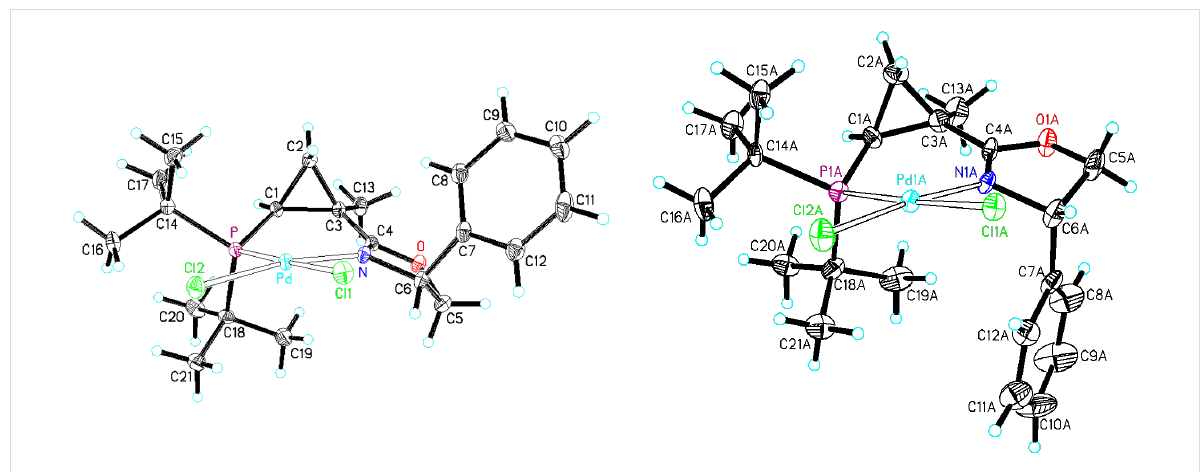
Figure 4: X-ray structures of complexes ( L1 )PdCl 2 (left) and ( L4 )PdCl 2 (right). These structures were originally communicated in